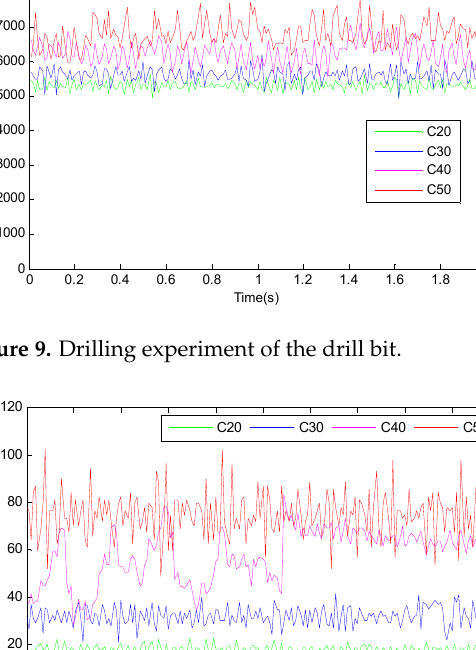
Figure 9. Drilling experiment of the drill bit. Figure 8. Drilling speed chart for bit drilling. Figure 8. Drilling speed chart for bit drilling.